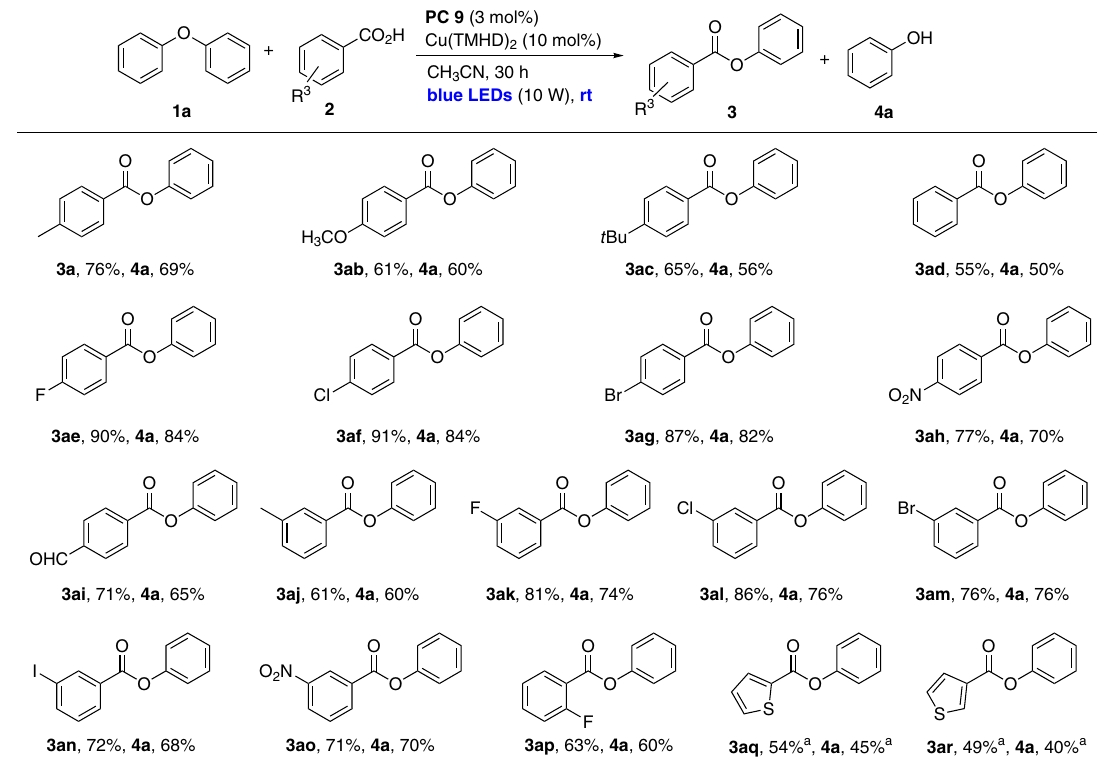
Fig. 3 Substrate scope of carboxylic acids. Reaction conditions: 1a (0.50 mmol), 2 (0.60 mmol), PC 9 (3 mol%), Cu(TMHD) 2 (10 mol%), CH 3 CN (5 mL), irradiation with blue LEDs (425 – 430 nm, 10 W) for 30 h. Isolated yields were reported. a 60